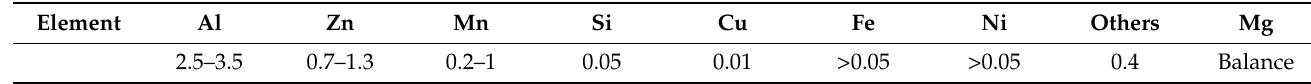
Table 1. Elemental composition by weight of AZ31 magnesium